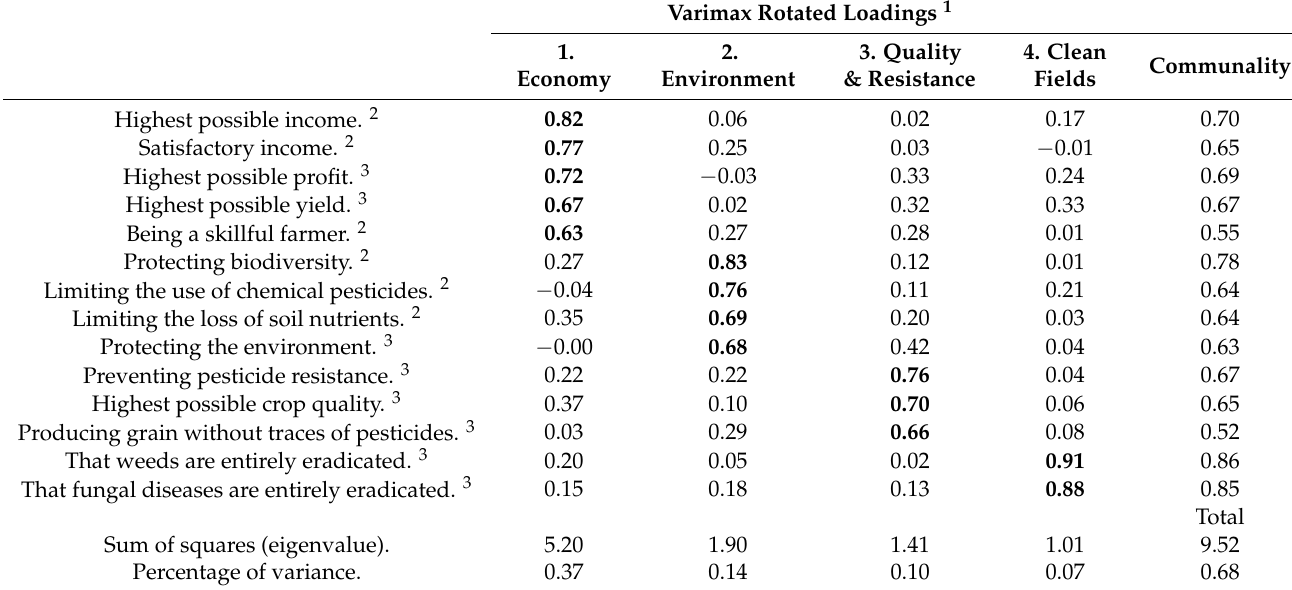
Table 6. Results from PCA of respondent evaluations of (1) which conditions are important for them as farmers and (2) what is important for them when they manage weeds and fungal diseases (Post-survey, N =